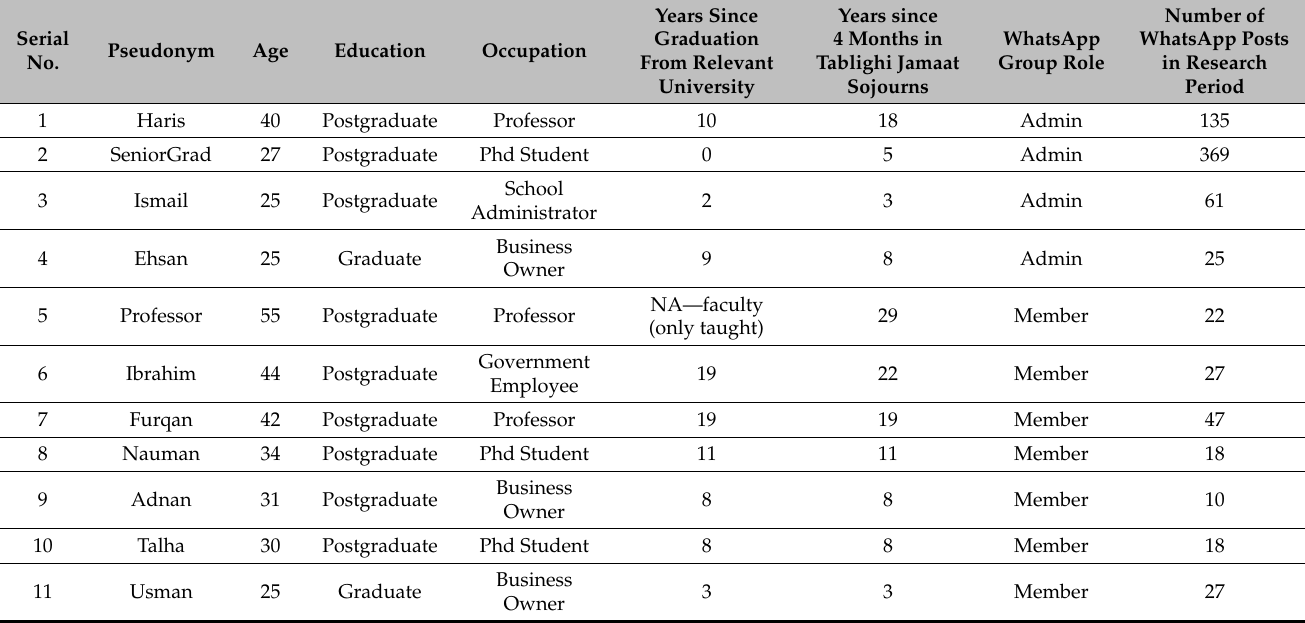
Table 1. Selected Profiles of WhatsApp Group